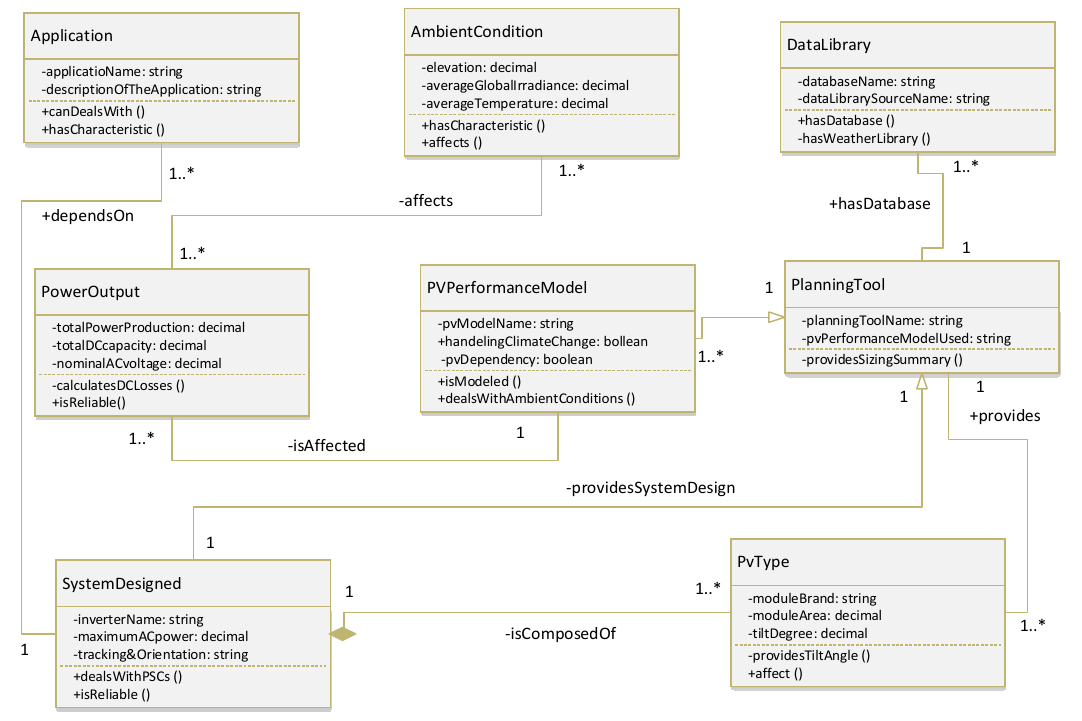
Figure 4. UML diagram of the key concepts associated with the PV planning.